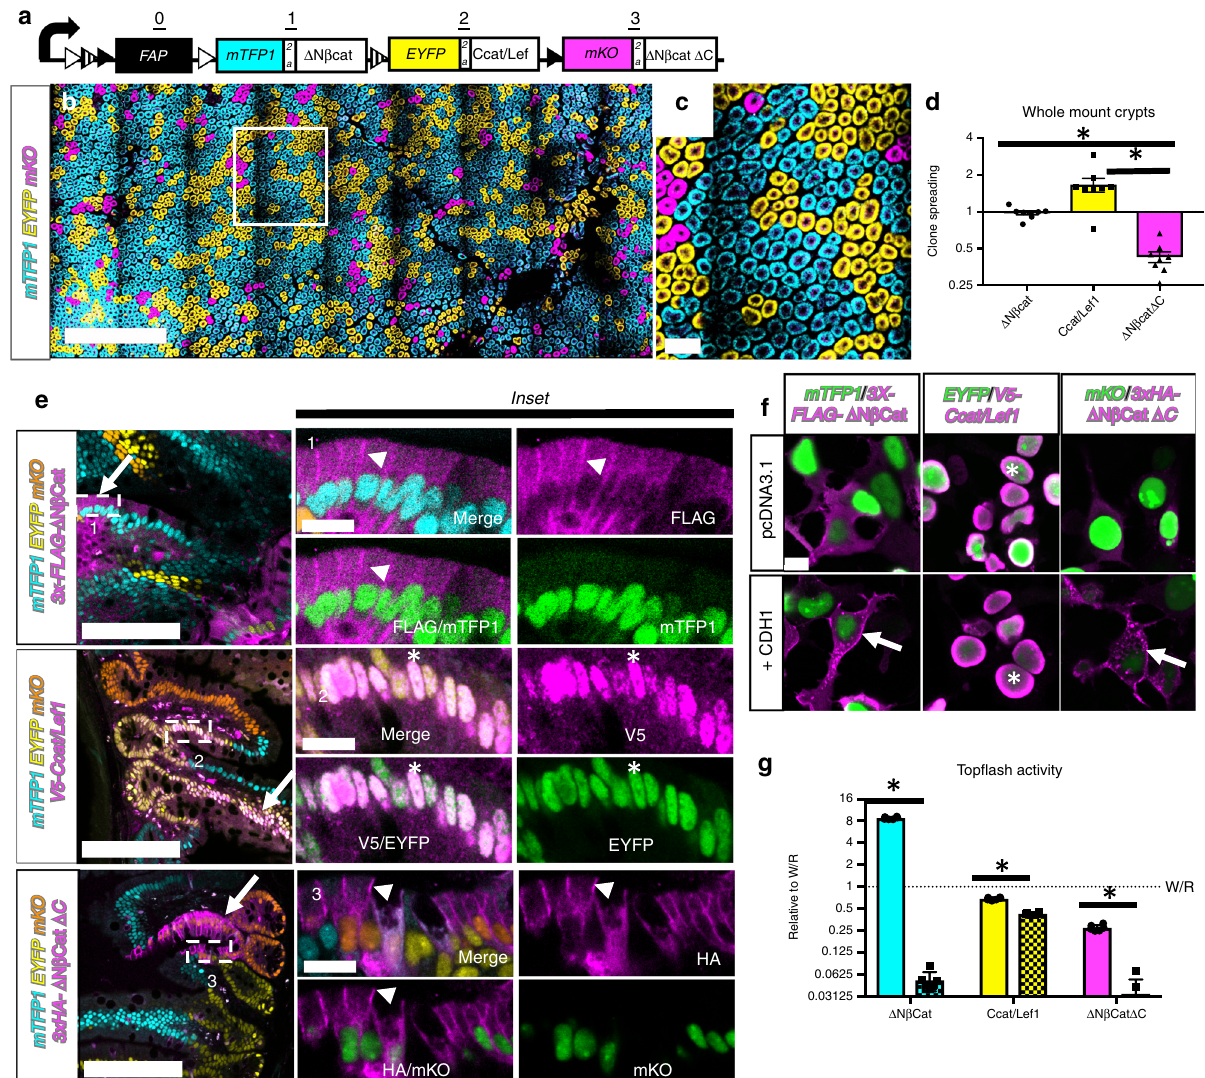
Fig. 3 Widespread expansion of oncogenic clones during perinatal development. a Diagram of MCAT-Crainbow mice. See also Table 1 and Supplementary Fig. 5. b MCAT VilCre small intestine ( N = 10 mice, 3 – 6 weeks of age) prepared as a wholemount and confocal imaged. c Inset in “ b ” at higher magni fi cation. d MCAT VilCre Crypts were color segmented, counted and normalized to the positional bias calculated in NCAT VilCre mice. Asterisk denotes statistical signi fi cance by one-way ANOVA (mTFP1 vs. EYFP: p = 0.003, mTFP1 vs. mKO: p = 0.016, EYFP vs. mKO = 3e – 6). e Immunostaining for FLAG, V5, or HA epitopes (magenta) speci fi c to each ßcat isoform in MCAT VilCre small intestine vibratome slices and merged with fl uorescent lineage markers (mTFP1: cyan, EYFP: yellow, and mKO: orange). Arrows denote isoform expression with cognate lineage reporter (FLAG and mTFP1, V5 and EYFP, and HA and mKO). Corresponding insets depict higher magni fi cation images. Arrowheads denote membrane-localized ßcat, whereas asterisk denotes nuclear-localized ßcat. Epitope stains (magenta) are also presented as merged and as a single-channel image with its cognate fl uorescent lineage reporter (green). f HEK cells were transiently transfected with MCAT isoforms, fi xed, stained, and imaged for the indicated epitope (magenta) and fl uorescent reporter (green). Cells were also cotransfected with epithelial cadherin ( CDH1 ) as indicated. Arrows denote sequestration of ßcat at the plasma membrane, and the asterisk denotes nuclear ßcat. g Wnt signalling activity for each oncogene in the absence of CDH1 (solid bar) or in the presence of overexpressed CDH1 (hatched bar) ( N = 6 wells per condition and independently repeated in four experiments). TOP FLASH activity was normalized to WNT/RSPO-stimulated control cells (dashed line). Asterisk denotes statistical signi fi cance by two-way ANOVA and Bonferroni ’ s multiple comparisons test (cyan < 1e – 6, yellow = 0.01, magenta = 0.02). (SEM included for each graph). Scale Bars = 1 mm in b , 100 µ m in c/e , 15 µ m in e: insets 1 – 3, and 10 µ m in f . Source data are provided as a “ Source Data fi le ” .